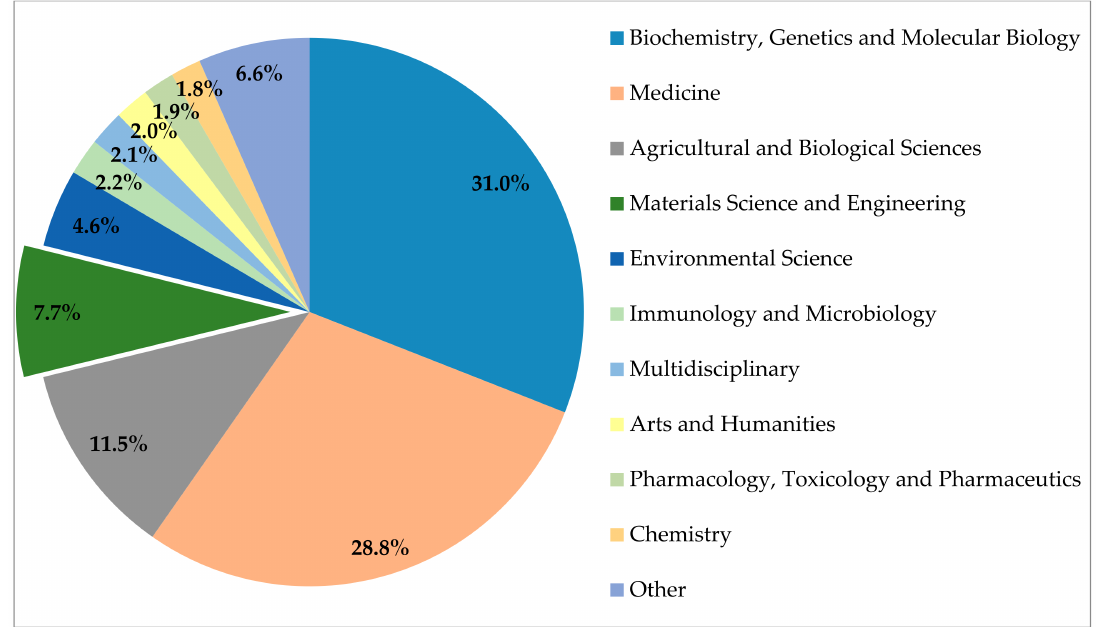
Figure 1. Number of publications with keywords “ra ffi a” or “raphia” by subject area reported by the Scopus database between 1910 and 2020